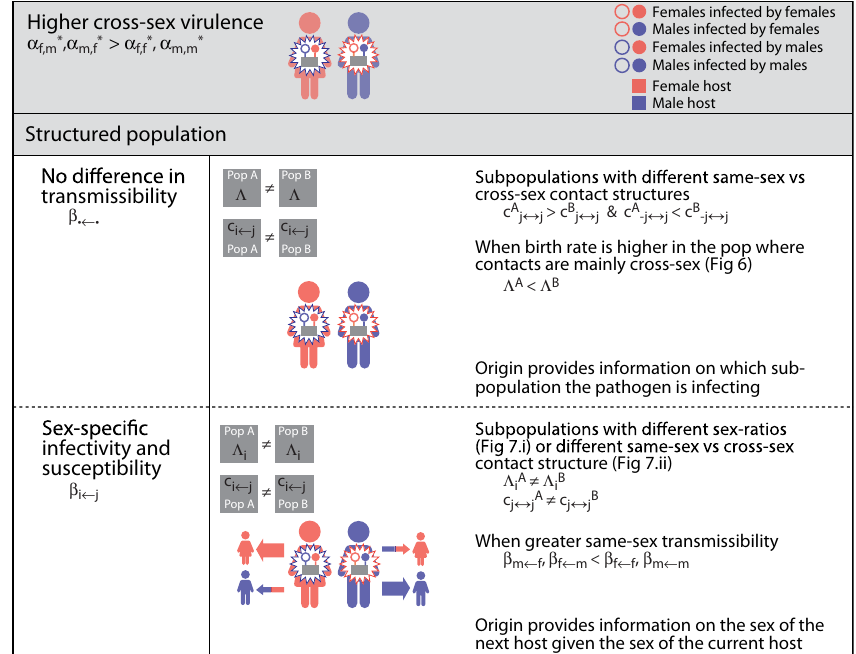
Fig. 9 Summary of results regarding the evolution of origin-&-sex-speci fi c virulence. We focus on the case when cross-sex virulence will be greater than same-sex one. Each row indicates a set of different assumptions regarding the population structure and pathogen ’ s